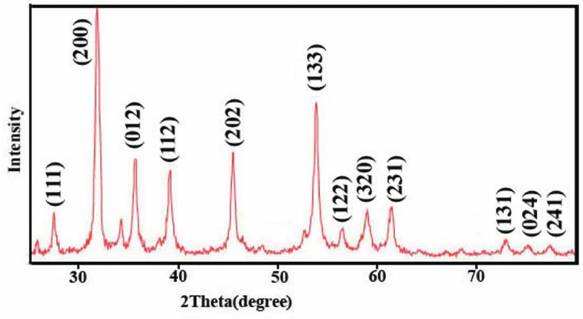
Figure 1: XRD pattern of NiS 2 nanostructure.